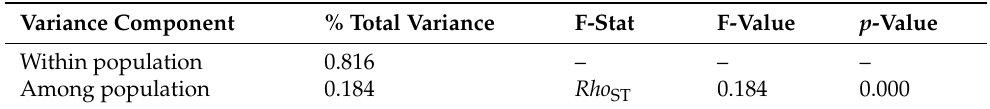
Table 1. Analysis of molecular variance (AMOVA) using an infinite allele model (reported statistics are equivalent to Rho ). Significance was tested using 10,000 permutations. Standard deviations of F-statistics were obtained through jackknifing over loci. A total of 95% confidence intervals of F-statistics were obtained through bootstrapping over